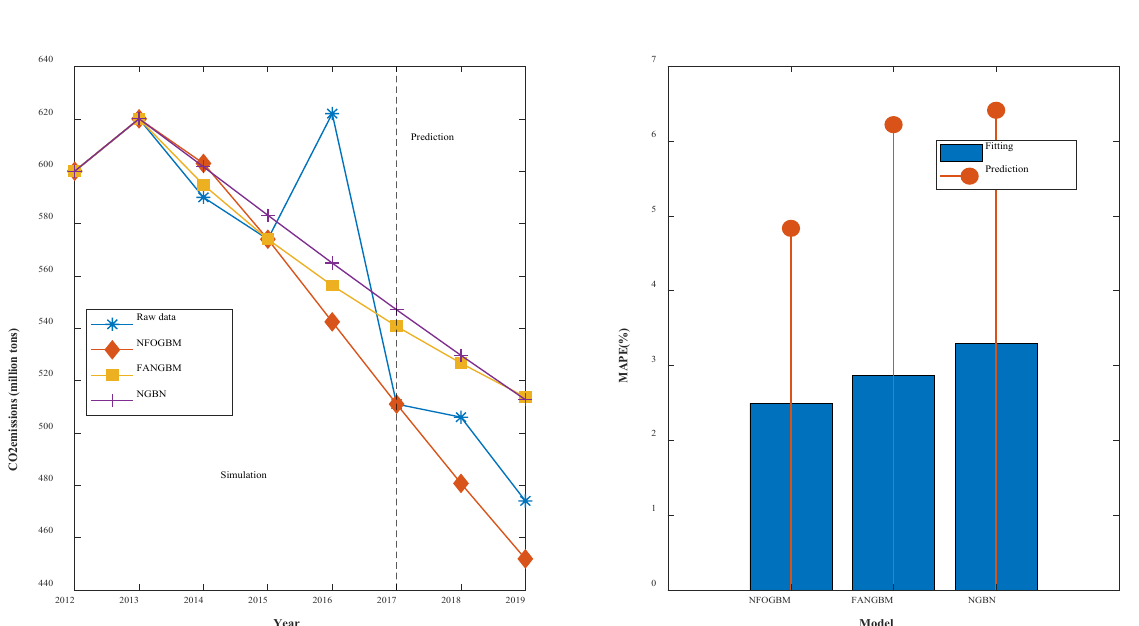
Figure 4. Fitting curves and error plots of the PNGE results. (3) The modeling results for TSPTS are shown in Table 4, and the fitting and error plots are shown in Figure 5. The MRPESs (%) of the NFOGBM, FANGBM, and NGBM are 1.52, 1.957, and 2.062, respectively; the MRFPEs (%) are 2.16, 6.244, and 3.806, respectively, and the CMRPEs (%) are 1.68, 3.028, and 2.498, respectively. In this example, the NFOGBM again yields the smallest simulation, prediction, and synthesis errors, and the highest modeling accuracy. Compared to the NGBM, the FANGBM yields some overfitting, which improves the simulation accuracy but leads to low prediction accuracy. Notably, the optimal solution of parameter α produced by the NFOGBM in this example is 1, implying that z ( r ) ( k ) = x ( r ) ( k − 1 )